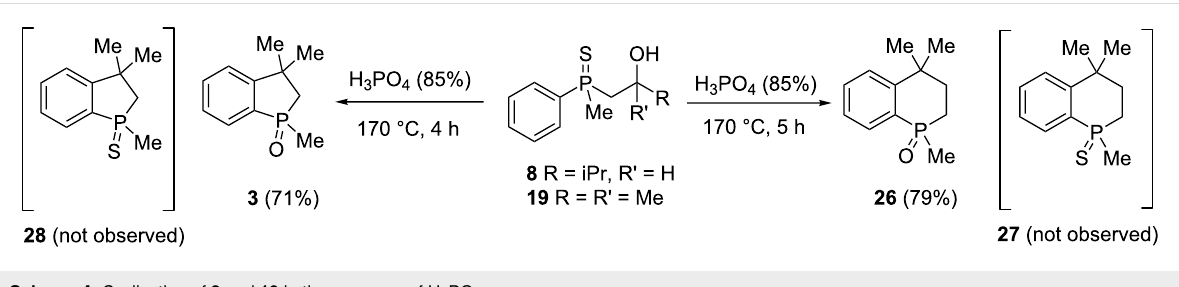
Scheme 4: Cyclization of 8 and 19 in the presence of H 3 PO 4 .